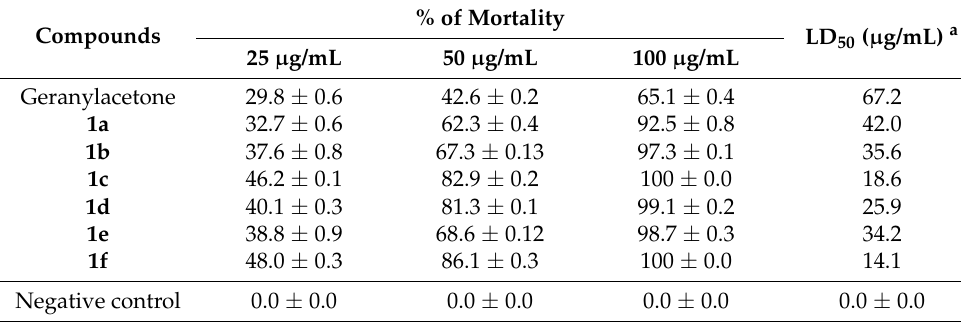
Figure 2. Structural relationship of geranylacetone derivatives. Table 1. Larvicidal effects of compounds ( 1a – 1f Table 2. Compounds (1a-1f) exhibit antifeedant activity.